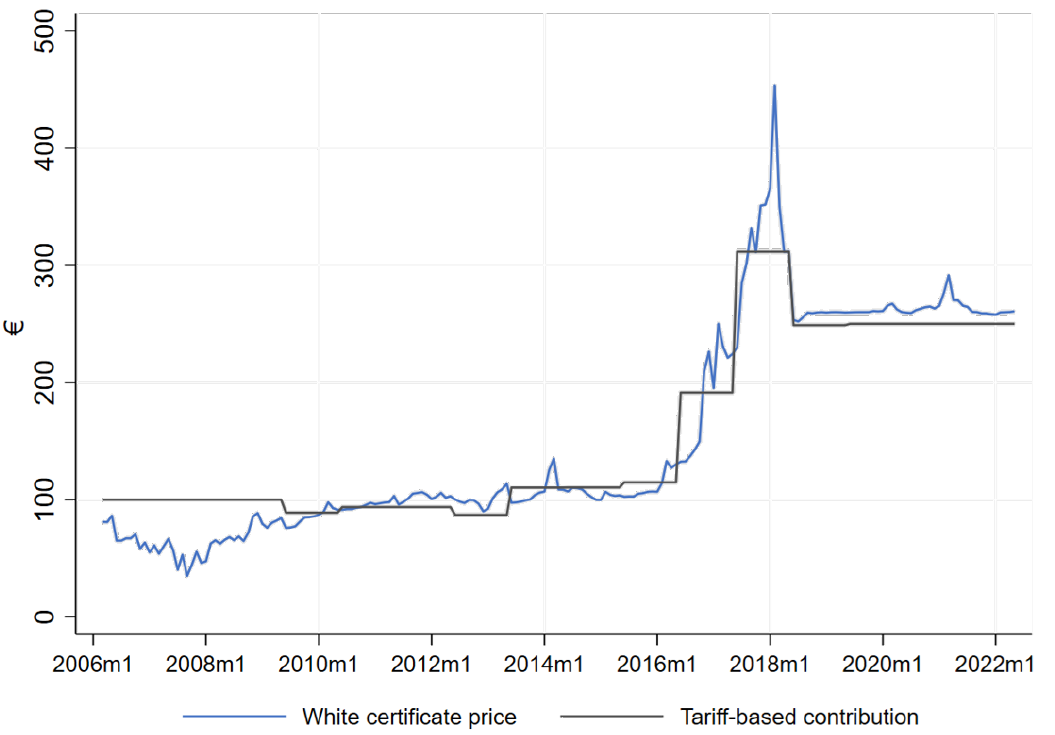
Figure 4. White certificate price and tariff contribution. Source: own elaboration based on available data from GME [47].